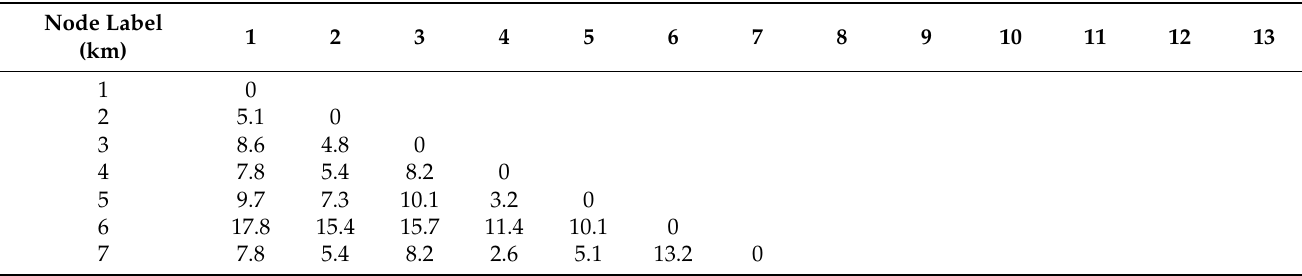
Table 5. Distance table between distribution